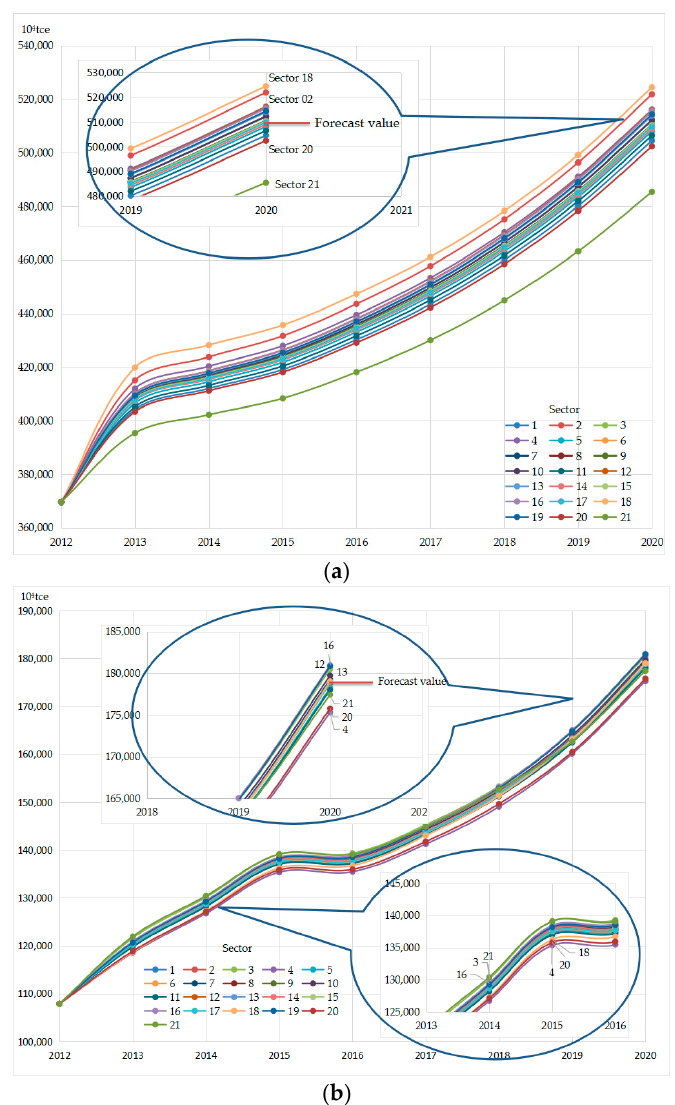
Figure 4. Energy consumption in the sensitivity analysis of the proportion of final demand for ( a ) TPEC and ( b ) EECS.